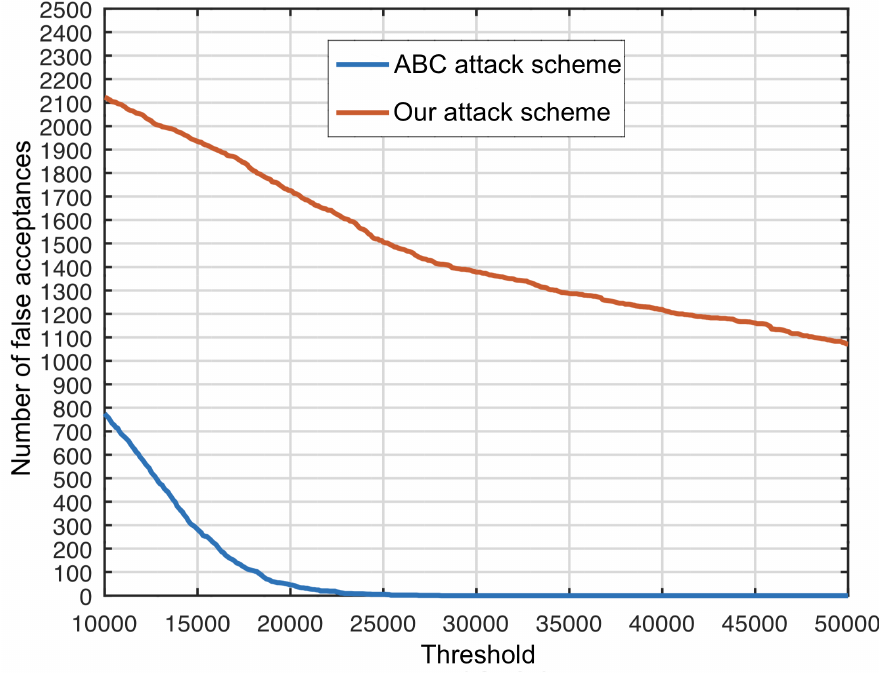
Figure 2. Number of false acceptances (on the vertical axis) bypassing both Forgery Detection and Removal Detection systems of the original ABC protocol, for the attack scheme proposed in [13] versus the attack scheme detailed in [6], when five images are used for PRNU estimation. False acceptances are counted for multiple PCE thresholds (on the horizontal axis) between 10,000 and 50,000, with a step of 100. Best viewed in